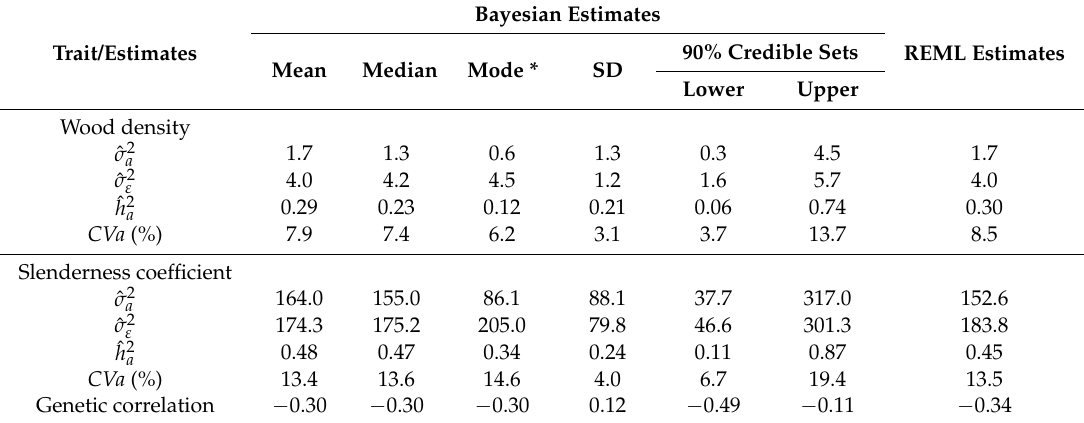
Table 2. Variance components, heritability for wood density (WD) and slenderness coefficient (SC), and the genetic correlation between the traits in the population of E. cladocalyx .